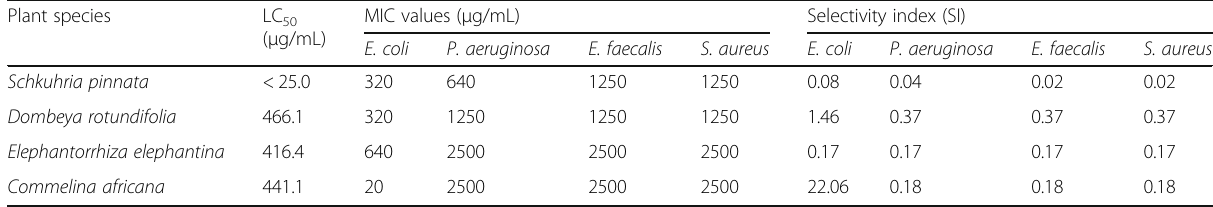
Table 3 Cytotoxicity, Minimum Inhibitory Concentrations (MIC), and selectivity index (SI) of the acetone extracts of the selected plants Plant